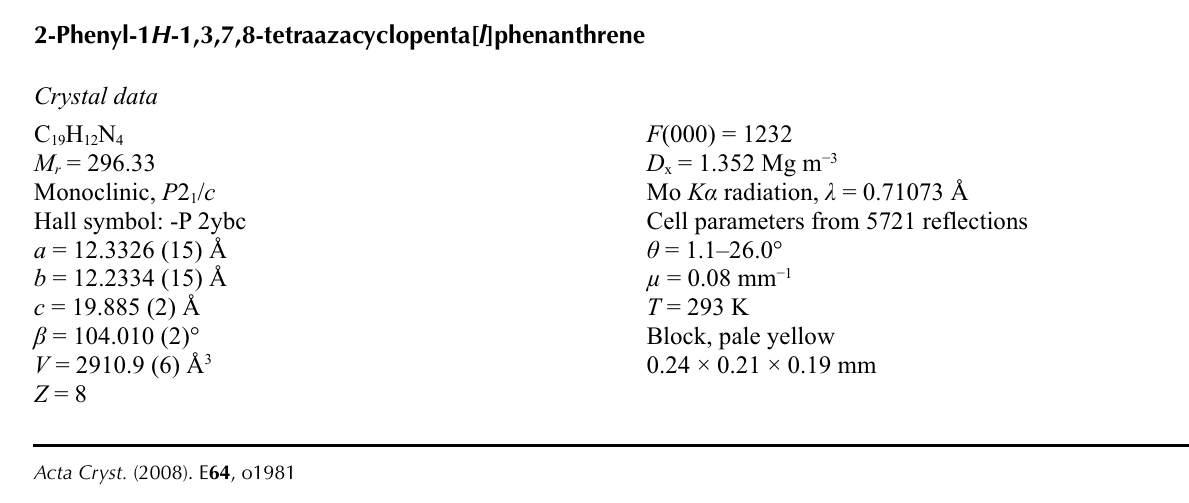
The structure of (I), showing the atomic numbering scheme. Displacement ellipsoids are drawn at the 30% probability